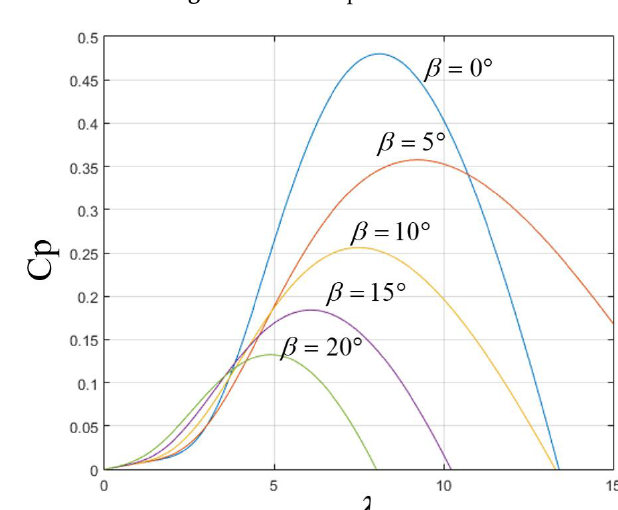
Figure 3. Turbine power curve.